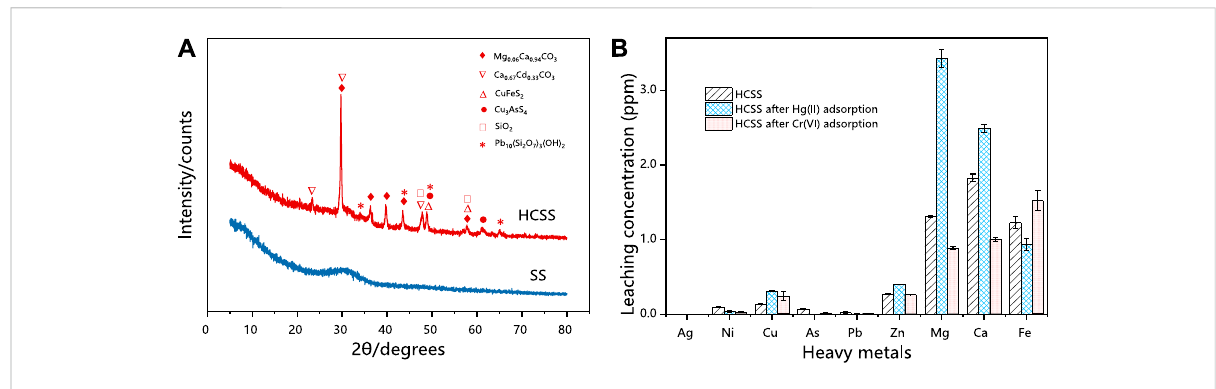
FIGURE 7 (A) XRD patterns of SS and HCSS. (B) Comparison of the different metal leaching concentrations of HCSS after Hg (II) and Cr (IV) removal. Conditions: C0 = 400 ppm; sample volume: 10 ml; dosage: 100.0 g/L; reaction time: 48 h; pH: 6.5; and temperature: 25 °